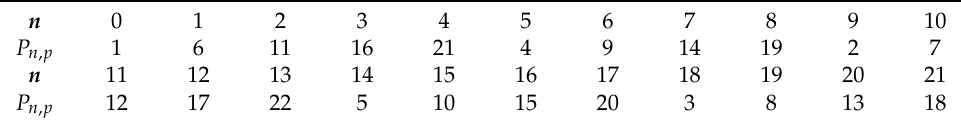
Table 2. Meshing sequence of planet gear for planetary gearbox 1.